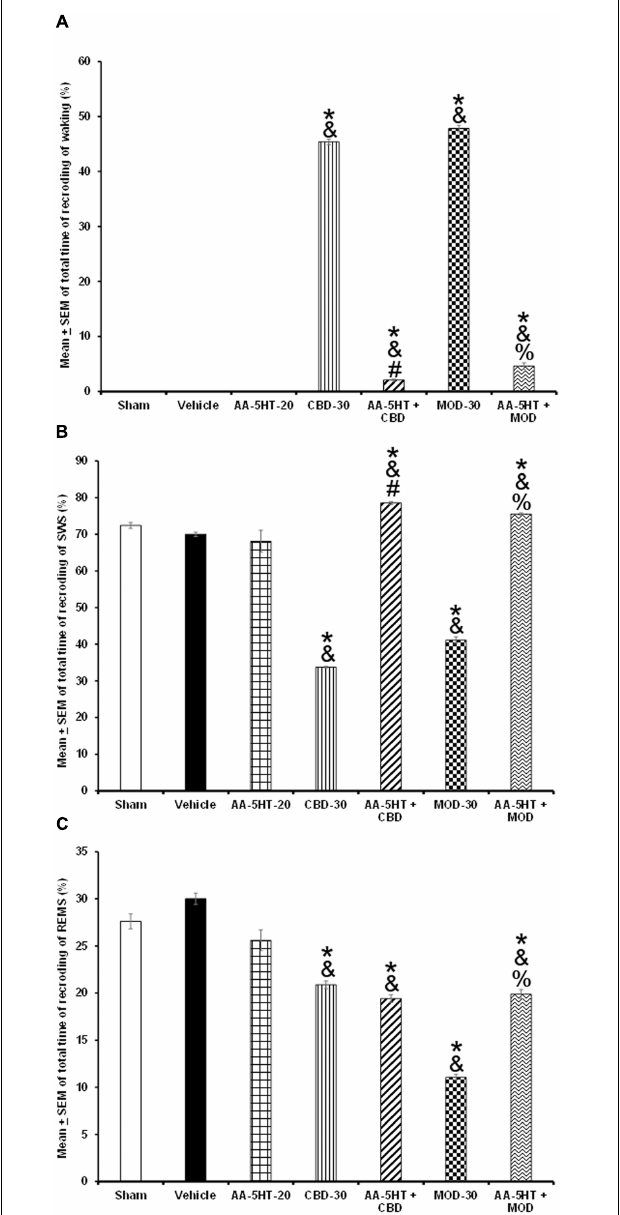
FIGURE 10 | Effects of experimental trials: Sham, vehicle, AA-5-HT (20 mg/Kg; i.p.), cannabidiol (CBD; 30 mg/Kg; i.p.), AA-5-HT (20 mg/Kg; i.p.) and 15 min later CBD (30 mg/Kg; i.p.), modafinil (MOD; 30 mg/Kg; i.p.) or AA-5-HT (20 mg/Kg; i.p.) and 15 min later MOD (30mg/Kg; i.p.) on W, SWS, or REMS during the sleep rebound period in sleep-deprived rats. AA-5-HT caused no statistical changes in W, SWS or Abbreviations: Cannabidiol 30 mg/Kg, i.p. (CBD-30), modafinil 30 mg/Kg, i.p. (MOD-30), AA-5-HT-20 mg/Kg (AA-5-HT-20).